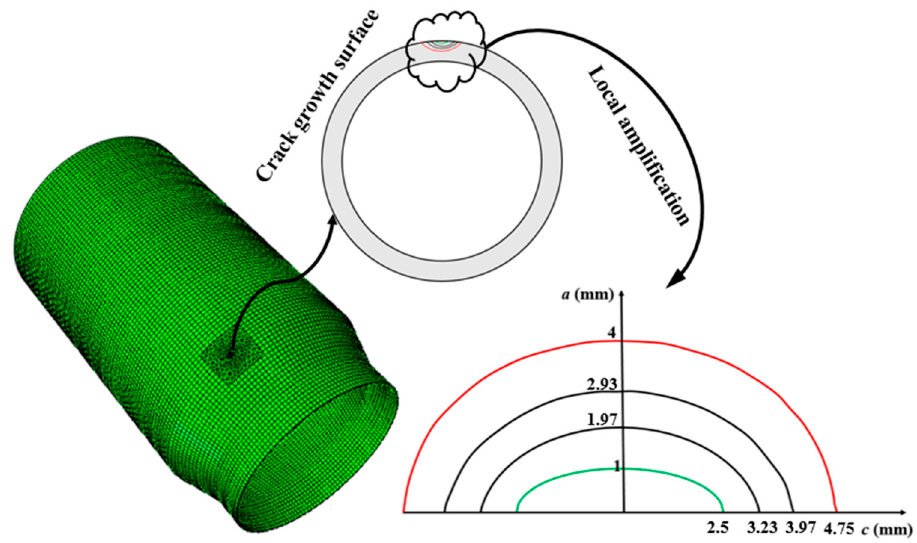
Figure 9. Change of crack surface during crack